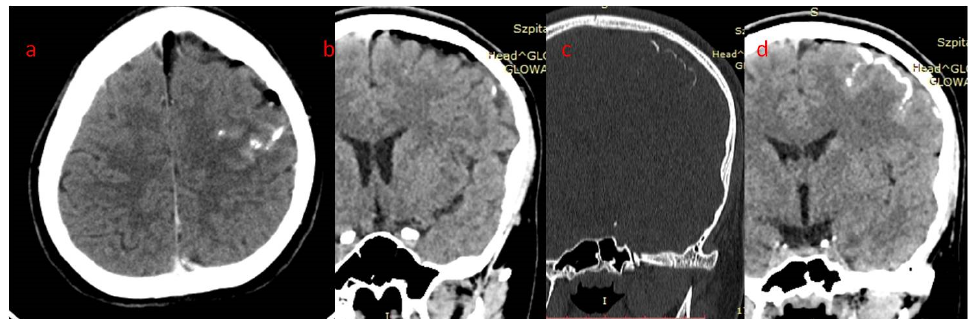
Figure 7. ( a – d ) Patient 2. Brain CT: gyral calcifications in left frontal lobe, coexisting subtle